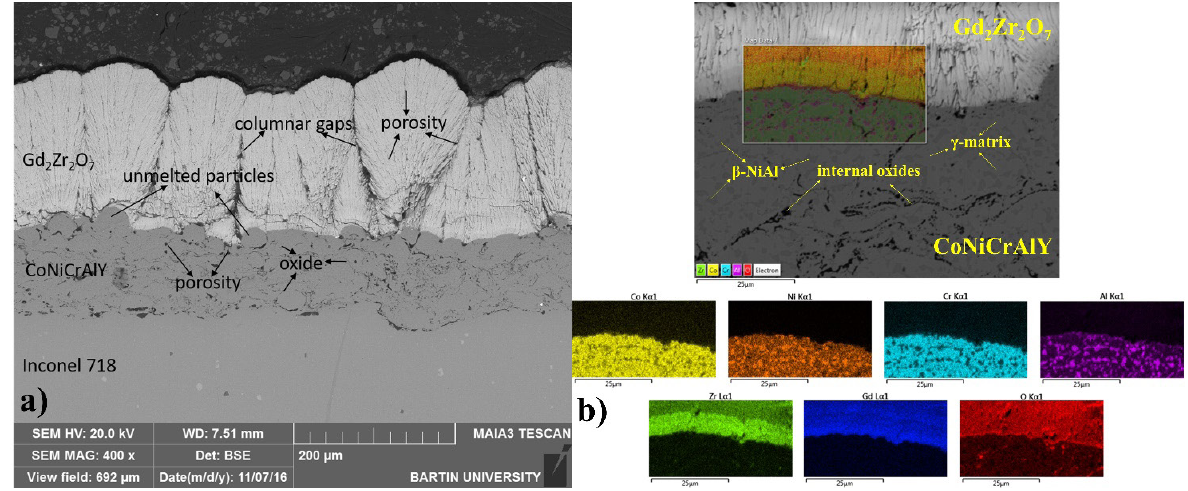
Figure 1: Cross-sectional a) SEM and b) elemental mapping images of as-deposited TBC.